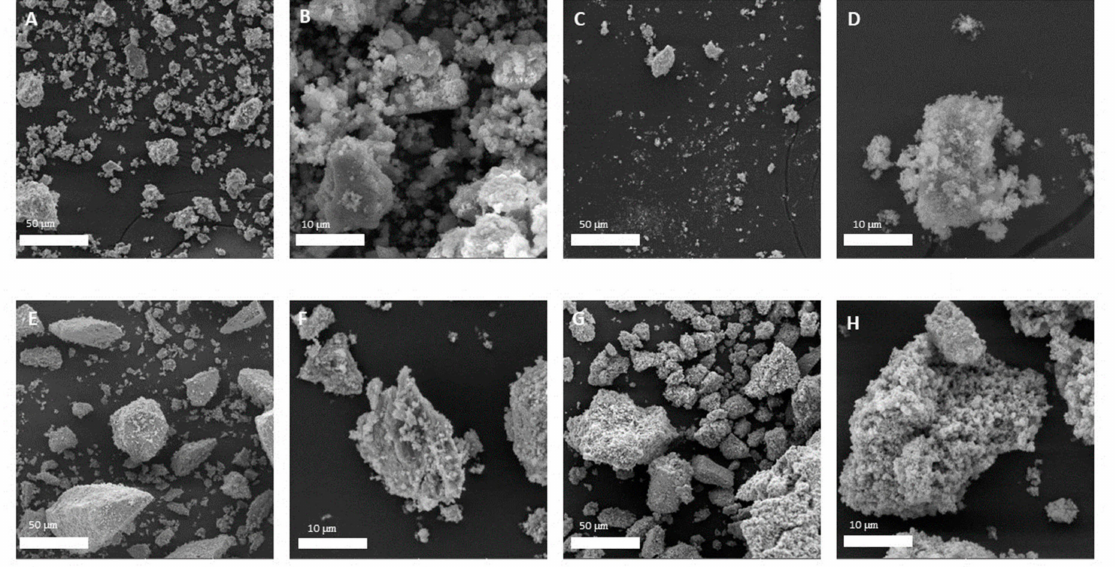
Figure 4. SEM images of the samples in 1kx ( A , C , E , G ) and 5kx ( B , D , F , H ) magnification for ZIF-8